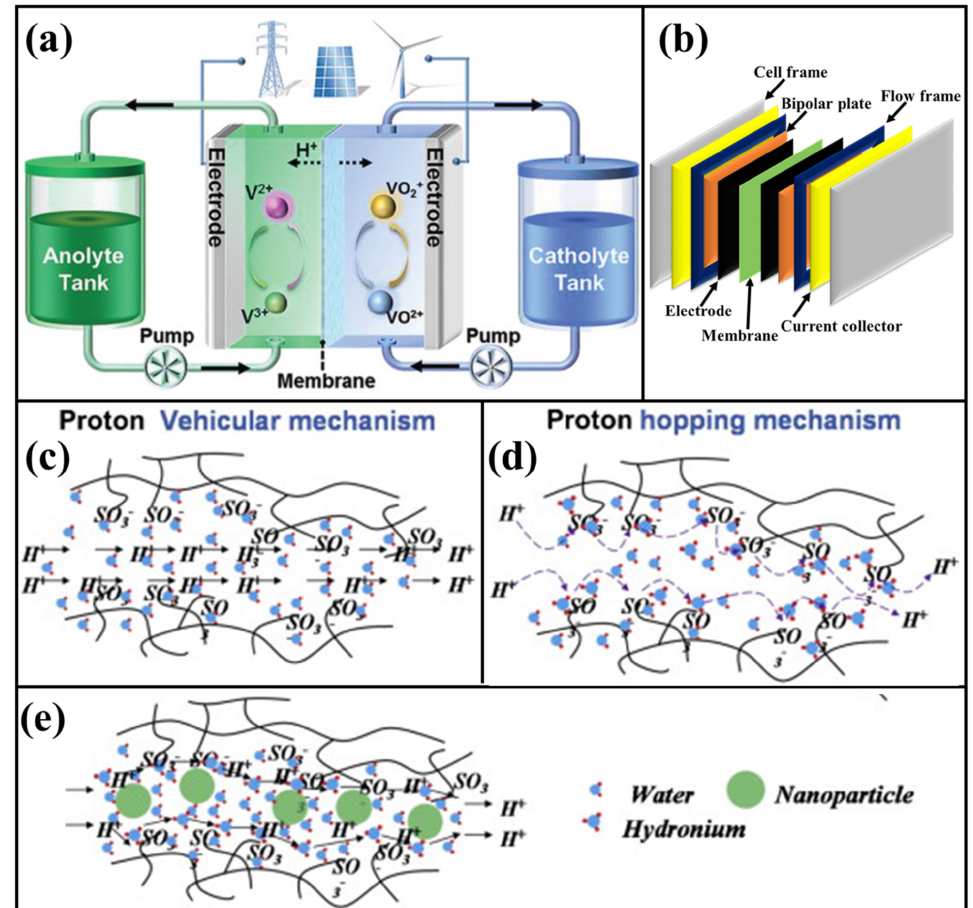
Figure 1. ( a ) Schematic representation of VRFB unit cell design and energy conversion process. Reprinted with permission from ref. [68]. Copyright © 2020 WILEY-VCH Verlag GmbH &